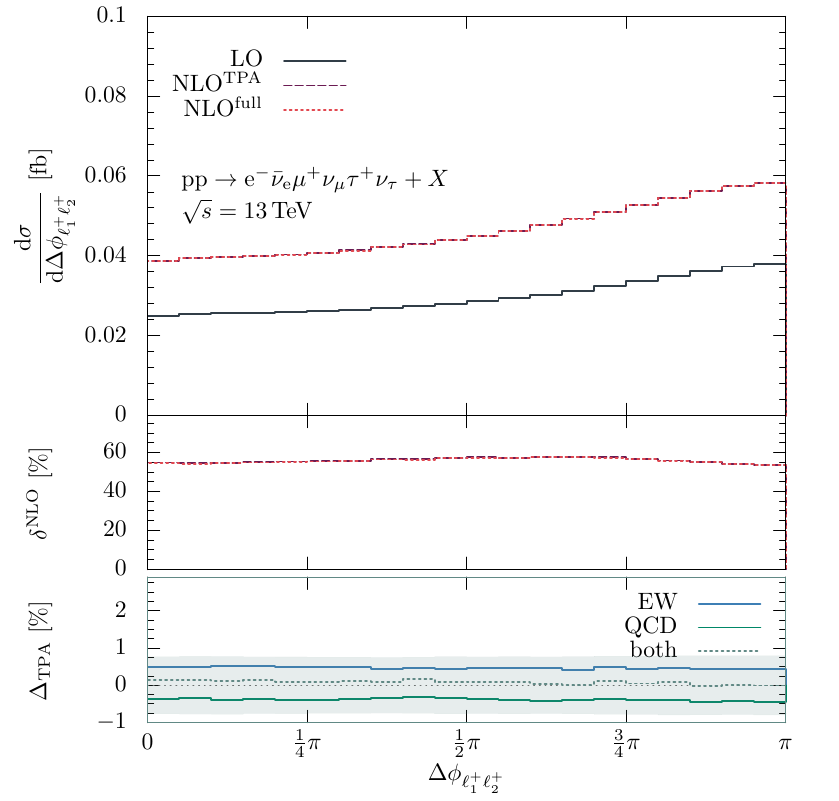
Figure 12. Di(cid:11)erential cross sections and relative corrections over the azimuthal-angle di(cid:11)erence (cid:1) (cid:30) of the two positively-charged leptons. The upper part shows the di(cid:11)erential LO cross ‘ + 1 ‘ + 2 sections and the NLO cross sections for the TPA and the full o(cid:11)-shell calculation. In the middle, the total NLO correction (cid:14) NLO for the TPA and the full o(cid:11)-shell calculation are depicted. The bottom panel shows the relative di(cid:11)erence (cid:1) TPA between the TPA and the full o(cid:11)-shell calculation if taking the TPA only in the NLO EW contributions, the NLO QCD contribution, or concurrently in both parts. The shaded gray area indicates the estimated size of (cid:1) TPA , (cid:1) estimate eq.